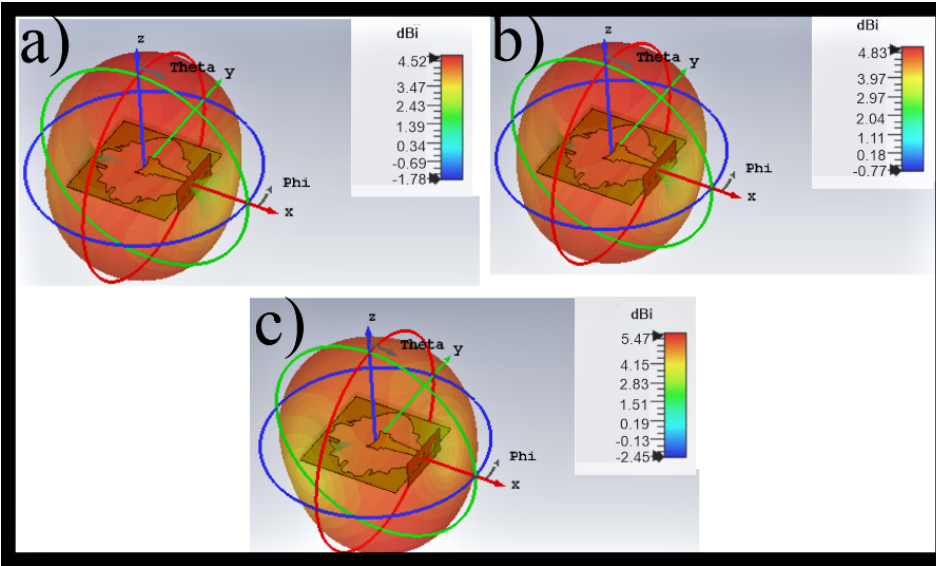
Figure 9. 3D Radiation patterns of single antenna: ( a ) 3.5 GHz; ( b ) 5 GHz; ( c ) 7.5 GHz.